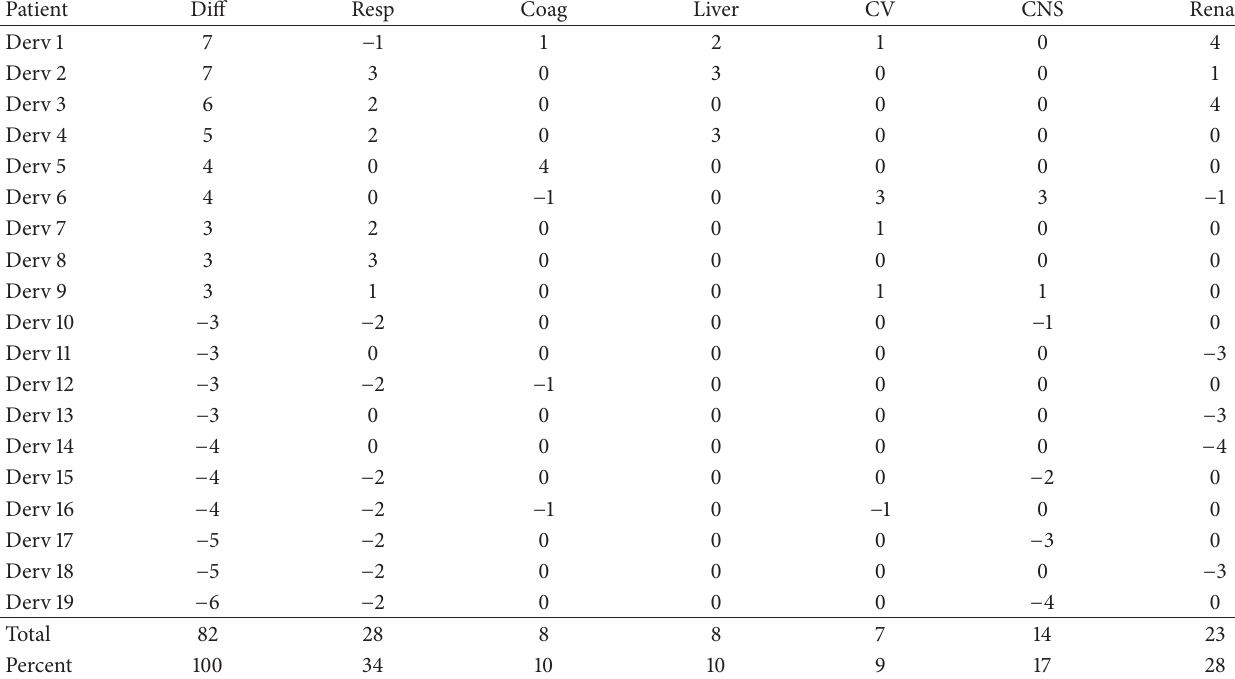
Table 2: Derivation cohort subset: difference (manual score − automatic score) greater than two. Difference in component scores is also included. Total represents the sum of the absolute value of the differences.